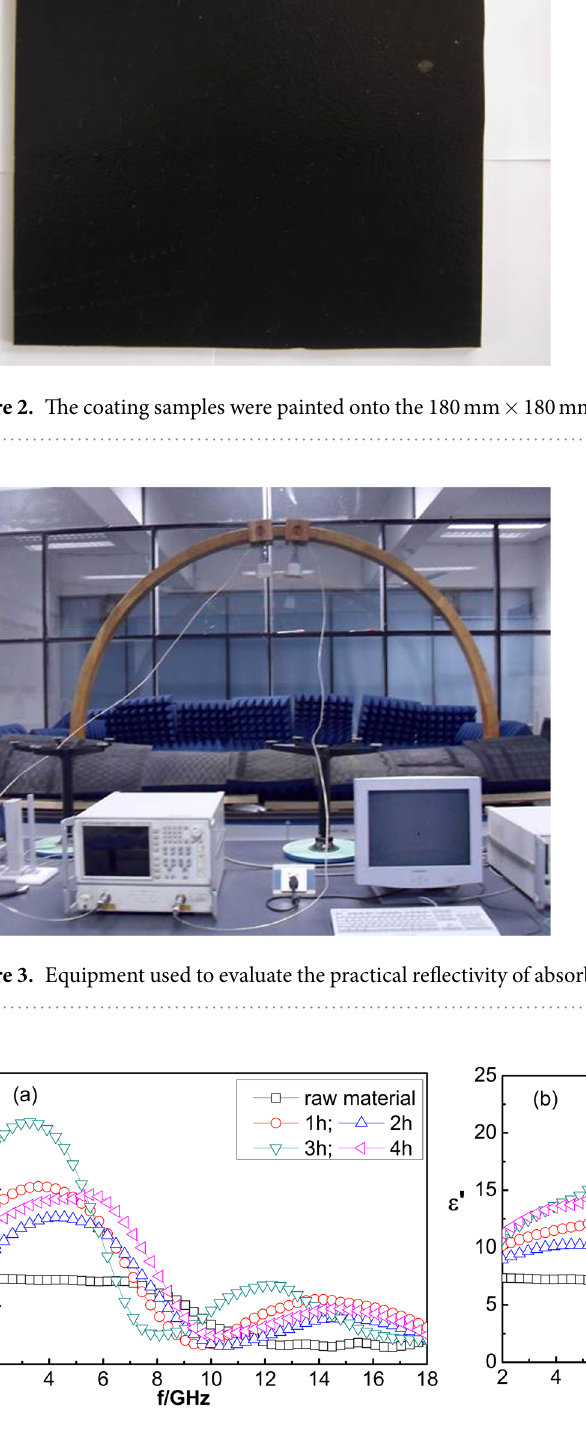
to a decrease in the dielectric constant. Short times are inadequate for complete optimization of the structure of the CNTs, whereas excessive times will lead to a decrease in the number of CNTs and electric dipoles. This will